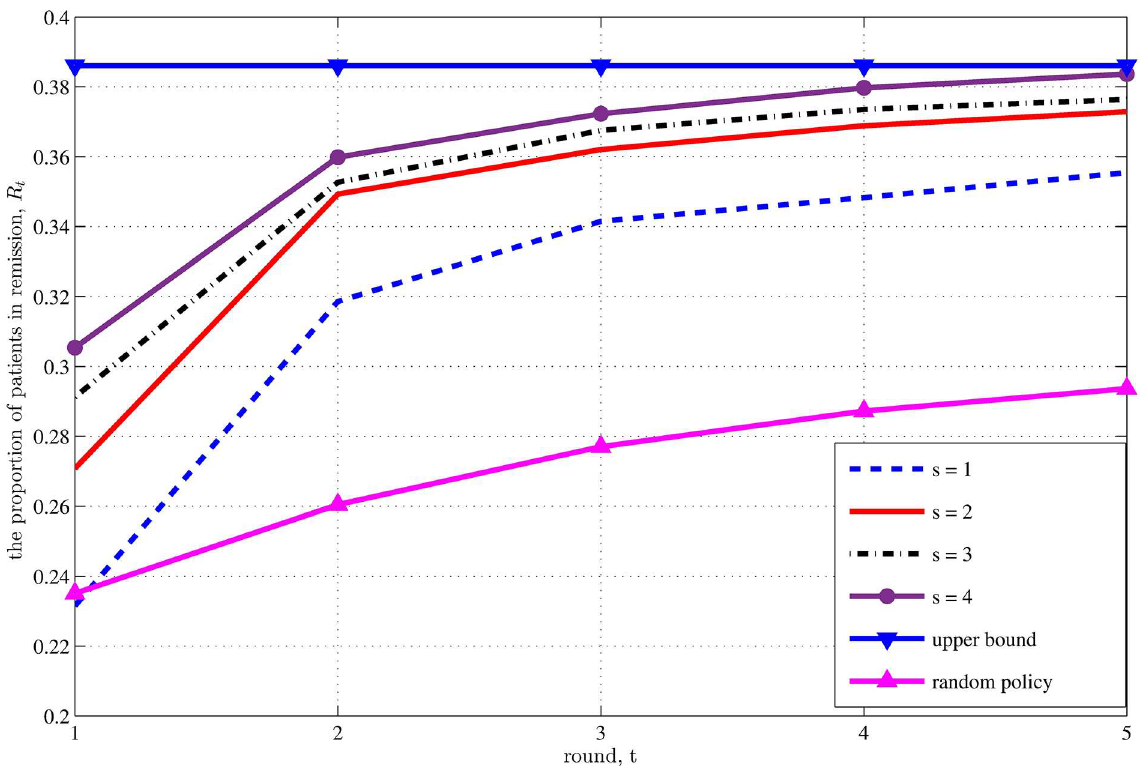
Fig 3. Results for the dependence version of the problem with D 1 = 5 initial